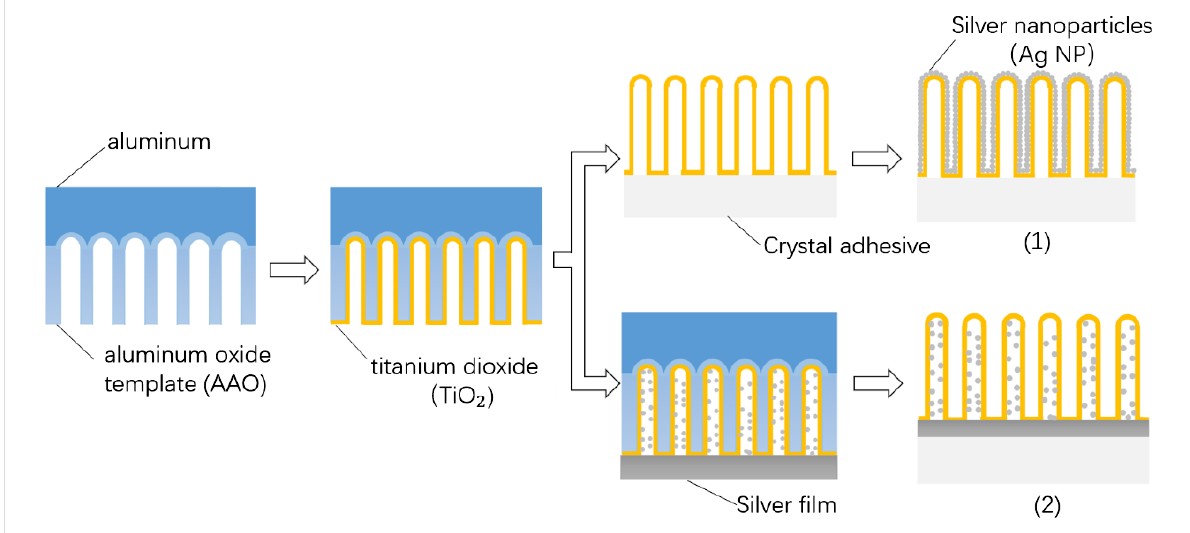
Figure 1: Schematic diagram of the preparation process of the different Ag–TiO 2 nanocolumn structures. (1) Structure of samples ACT1, ACT2, and ACT3; (2) structure of samples AFT1, AFT2, and AFT3.